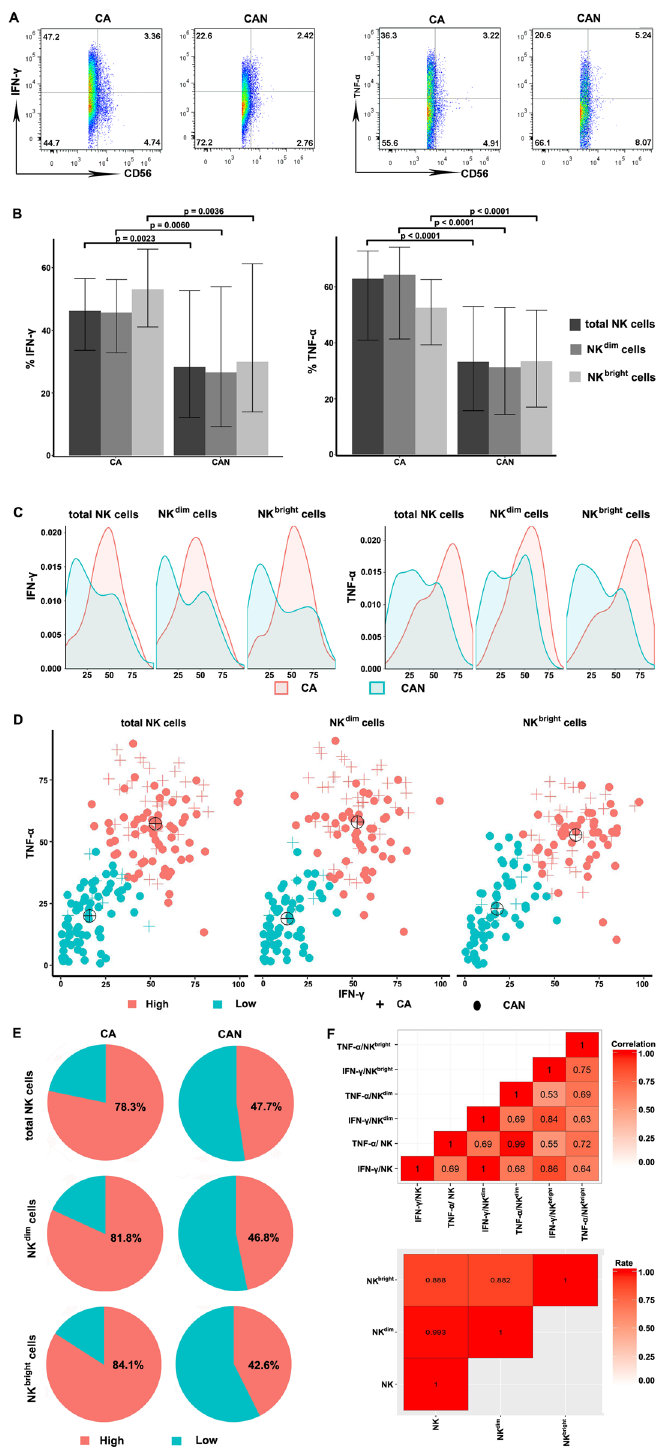
Figure 2. Quantification of cytokine productions by NK cells and their subsets in CHB patients. ( A ) FACS plot showed the representatives of IFN- γ and TNF- α produced by NK cells in CA and CAN groups. ( B ) The production of IFN- γ and TNF- α by NK cells and their subsets were compared between patients in CA and CAN groups and healthy controls. The comparisons were using Mann-Whitney test. ( C ) Overlapping sections of cytokine distribution signify the proportion of patients with similar abilities to produce cytokines in the two patient groups. ( D ) Clustering of CHB patients with IFN- γ and TNF- α produced by total NK (left), NK dim (middle) and NK bright (right) cells using the K-means method. Black targets represent the cluster centres. The high or low levels of IFN- γ and TNF- α clusters are shown in red or blue colours, respectively. The crosses and circles represent CA and CAN patients, respectively. ( E ) Pie charts show the percentage of total NK, NK dim and NK bright cells able to produce high (red) or low (blue) levels of cytokines in the indicated categories of